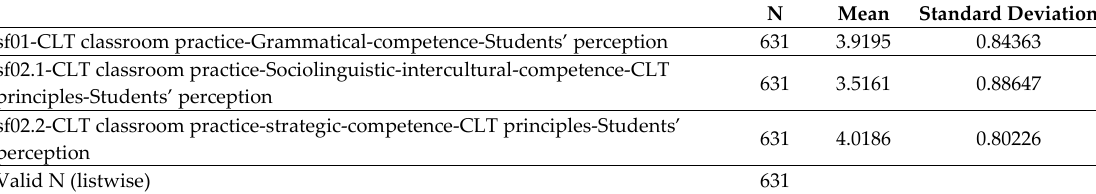
Table 1. students’ perception of CLT